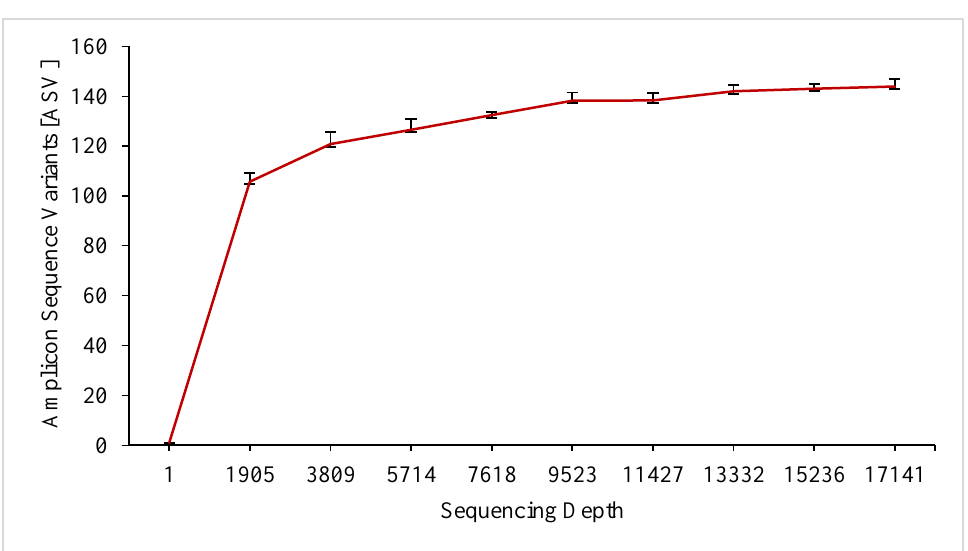
Figure 2. Rarefaction curve of microorganisms for the collective sample obtained from the 8- and 25-year-old implants.